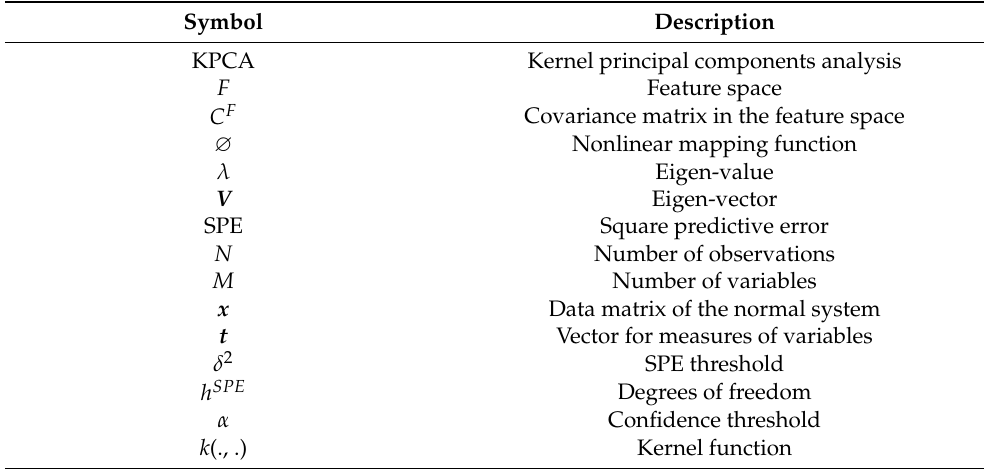
Table 1. Acronyms and notations used in the present